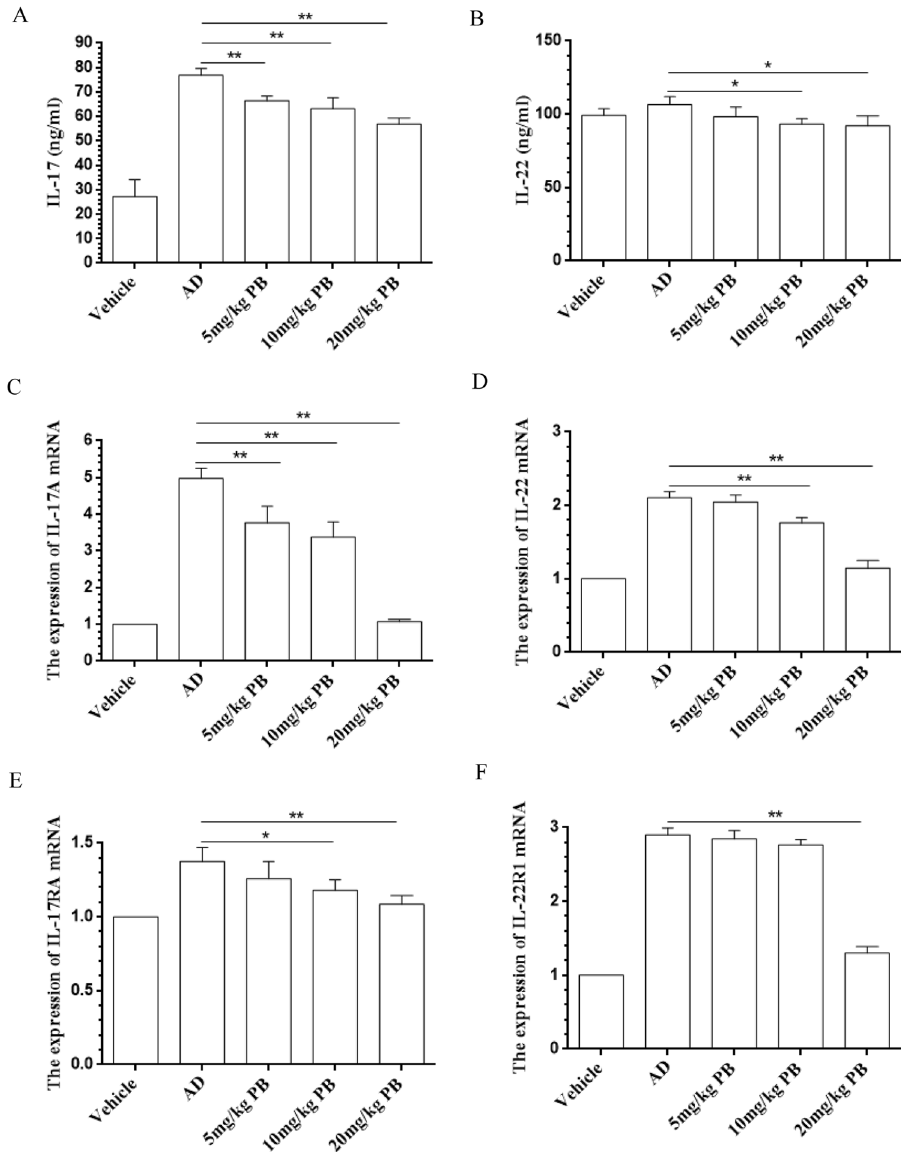
Figure 4. Inhibition of PB on IL-17 and IL-22 in NC/Nga mice. The concentration of serum IL-17 ( A ) and IL-22 ( B ) measured by ELISA. The expression of IL-17A ( C ), IL-22 ( D ), IL-17RA ( E ) and IL-22R1 ( F ) in the lesional skin tissues were evaluated by qRT-PCR and expressed as fold induction relative to vehicle. Data are representative of two independent experiments and presented as mean ± SD of n = 8 mice per group. * p < 0.05, ** p < 0.01. Vehicle, intact mice with saline treatment; AD, DNFB-sensitized and challenged mice; PB, pseudolaric acid